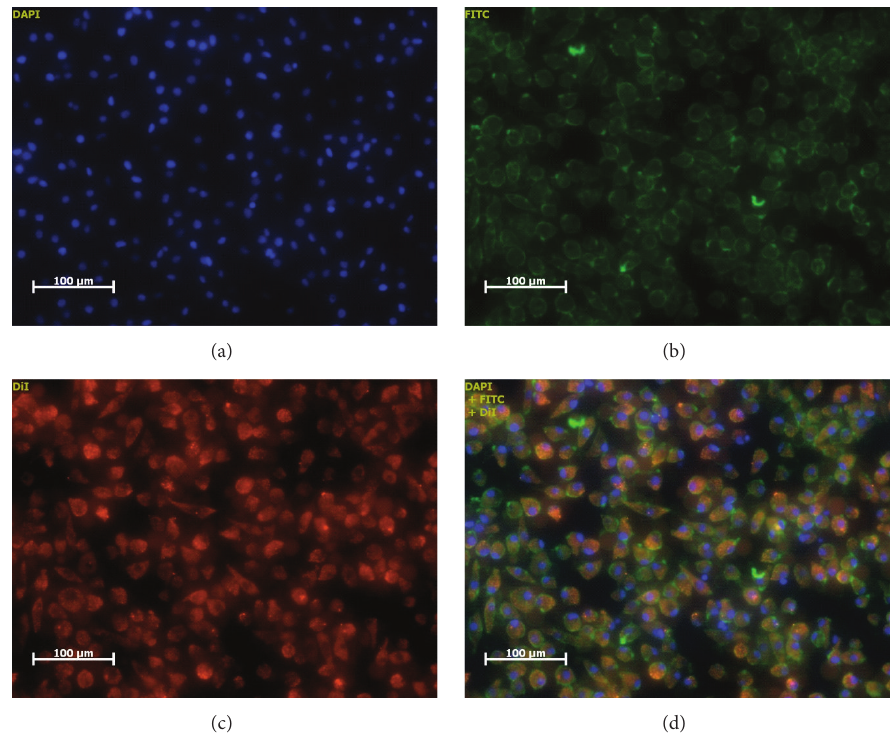
Figure 3: After 5 days of culture in the presence of VEGF and statin, the cells were stained with DAPI (a), UEA-1 lectin (b), Dil-acetylated LDL (c), and merge image (d). The cells exhibit the ability to bind lectin and uptake ac-LDL, one of the characteristics of eEPCs. Original magnification ×